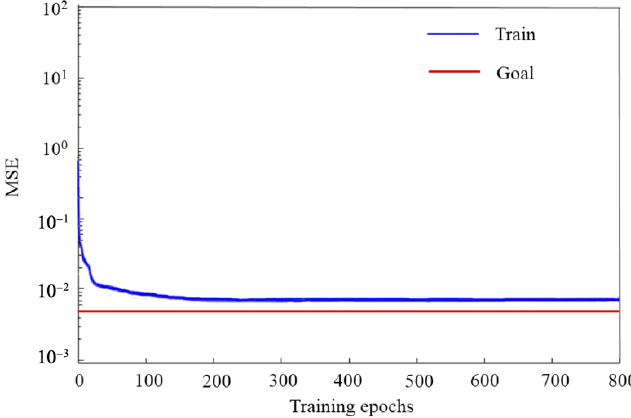
Figure 5. The training error curve of the 4-8-1 BP neural network.